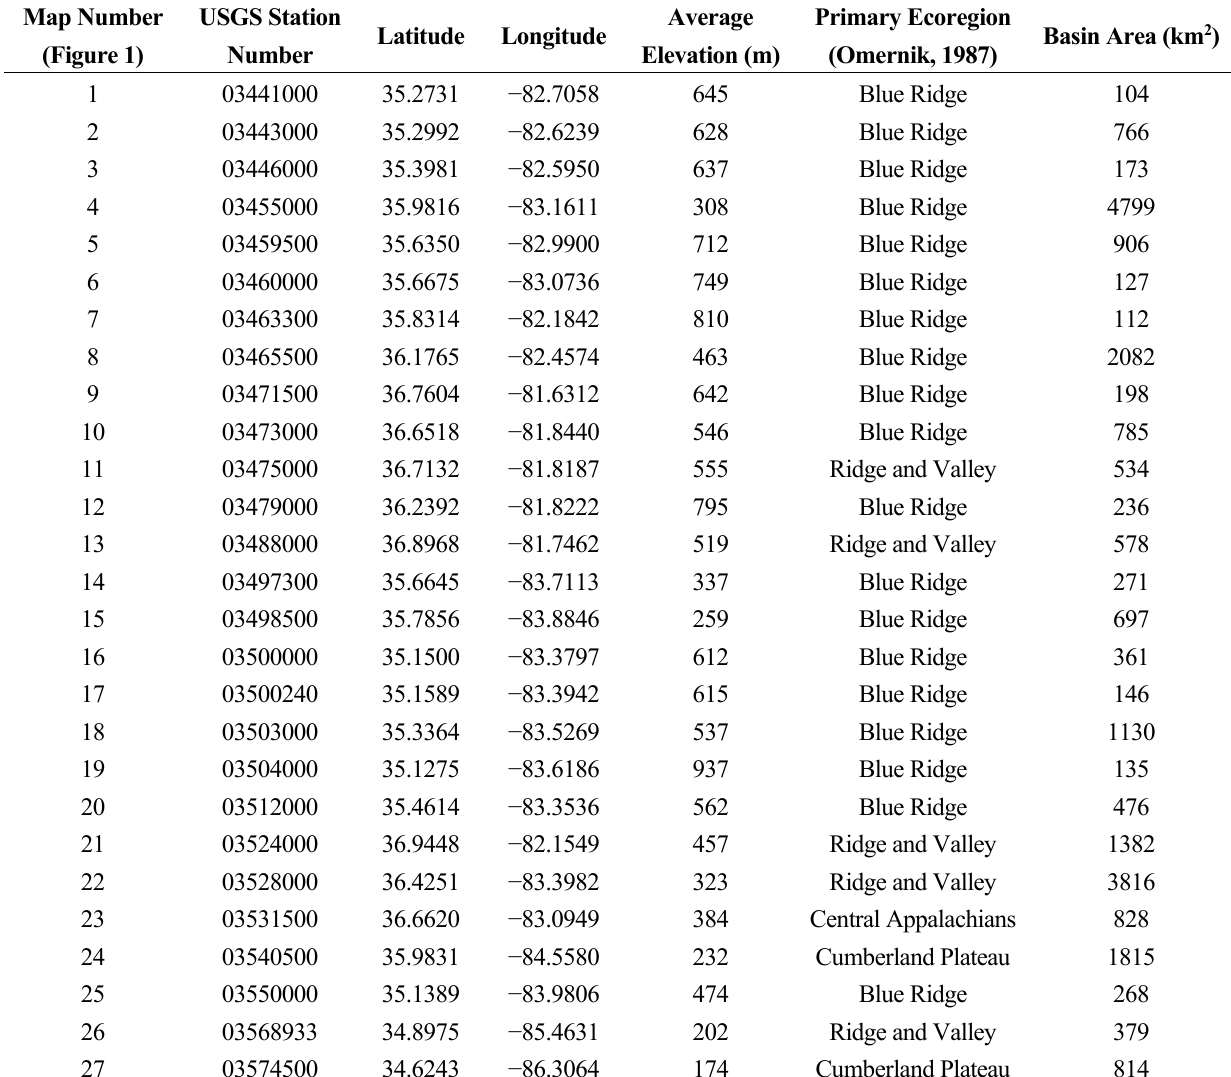
Table 1. U.S. Geological Survey (USGS) stream gaging sites used for model calibration and error evaluation. Latitude and longitude represent the basin outlet; ecoregion defined as the Level 3 ecoregion with the majority of the basin area; km 2 , square kilometers; horizontal reference is North American Datum 1983; vertical reference is North American Vertical Datum